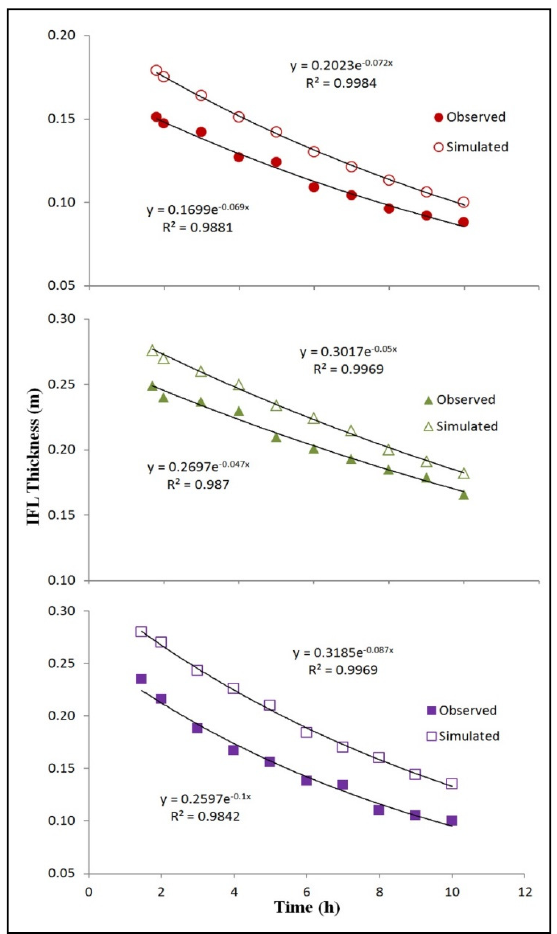
Figure 10. Observed vs. simulated thicknesses with best fit exponential regression lines to represent IFL degradation for Simulation 1 (red circles), Simulation 2 (green triangles), and Simulation 3 (purple squares).